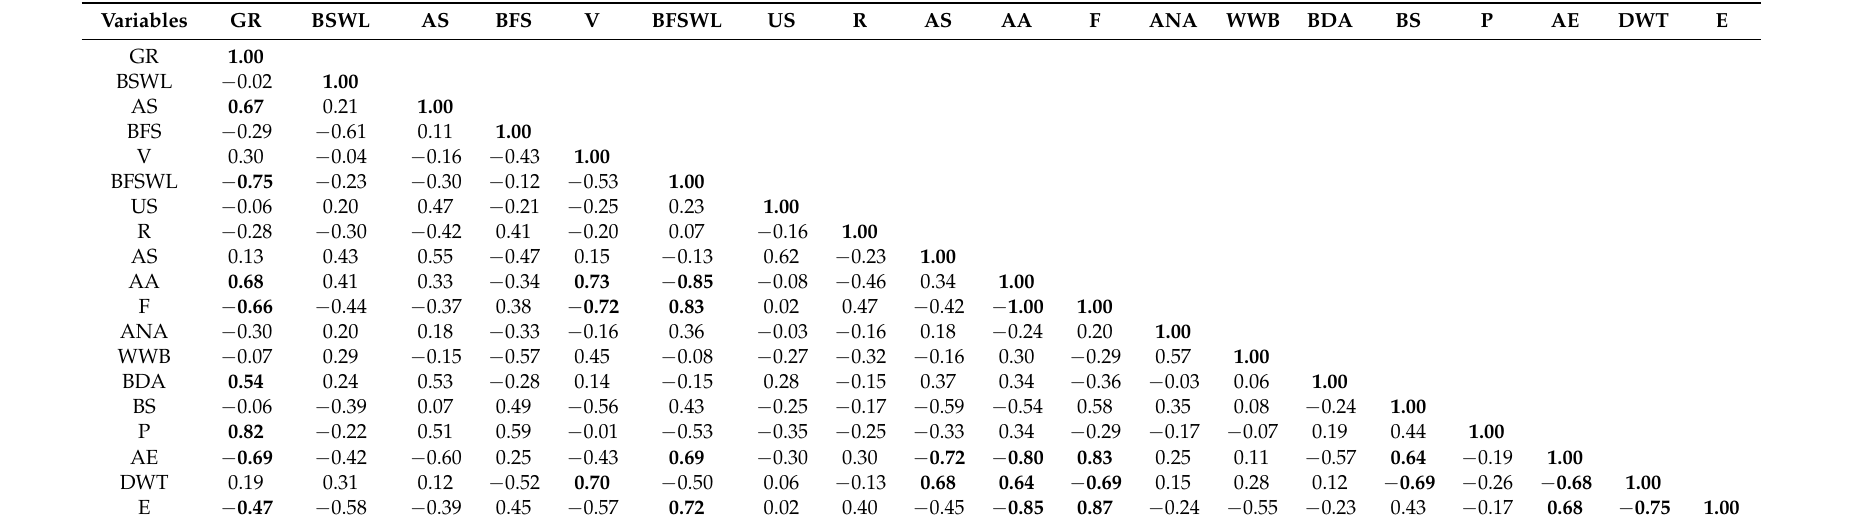
Table 5. Correlation analysis of catchment